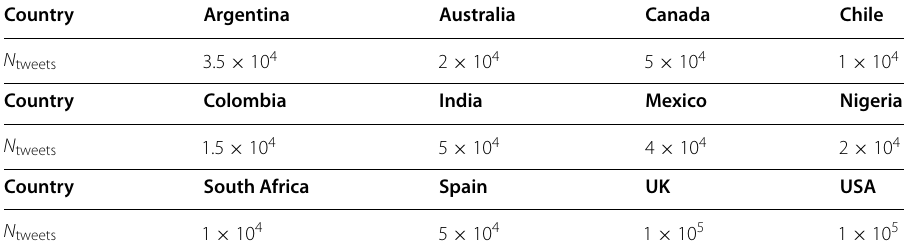
Table 9 Number of tweets taken per snapshot for each country Country